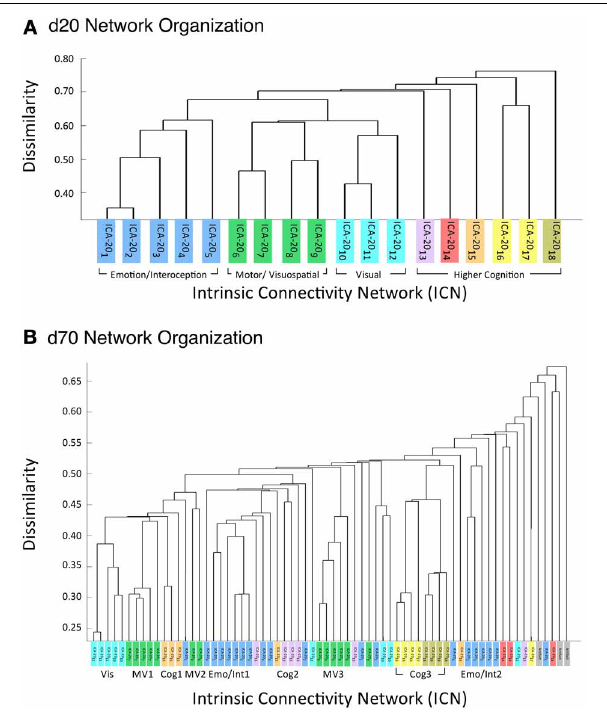
FIGURE 6 | HCA of BrainMap-based ICNs at d = 20 and d = 70 provide insight into how low-model order networks fractionate into high-model order sub-networks. (A) Network clustering of the d = 20 decomposition revealed three clear groupings of highly similar networks: emotional and interoceptive networks (blue), motor and visuospatial networks (green), and visual networks (cyan). The remaining components were associated with higher cognitive processes (warm colors). The cognitive networks were behaviorally dissimilar across components and other network groups, as indicated by high branching points in its dendrogram. (B) Network clustering of the d = 70 decomposition exhibited generally similar network organizational properties with the d = 20 dendrogram, but included subtle fractionation properties indicative of non-homogenous behavioral functions. The left–to–right ordering of networks in the above dendrograms are the same as presented in Figure 5 . Vis, visual; M/V, motor and visuospatial; Cog, cognitive; Emot/Int, emotional and